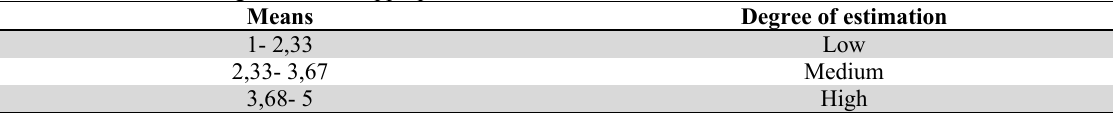
Measurement for deciding the level of appropriateness of the means